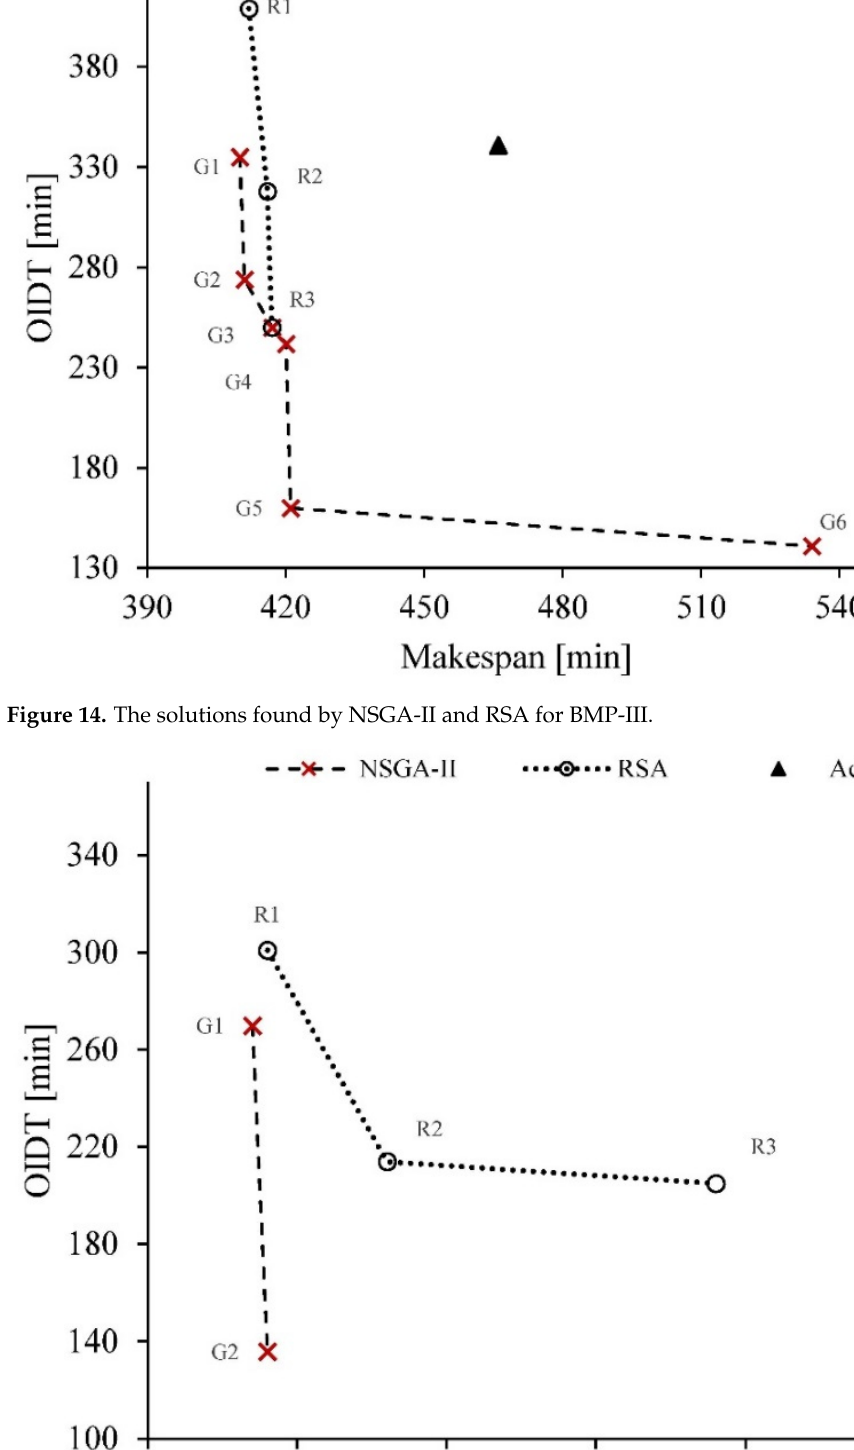
Figure 14. The solutions found by NSGA-II and RSA for BMP-III.